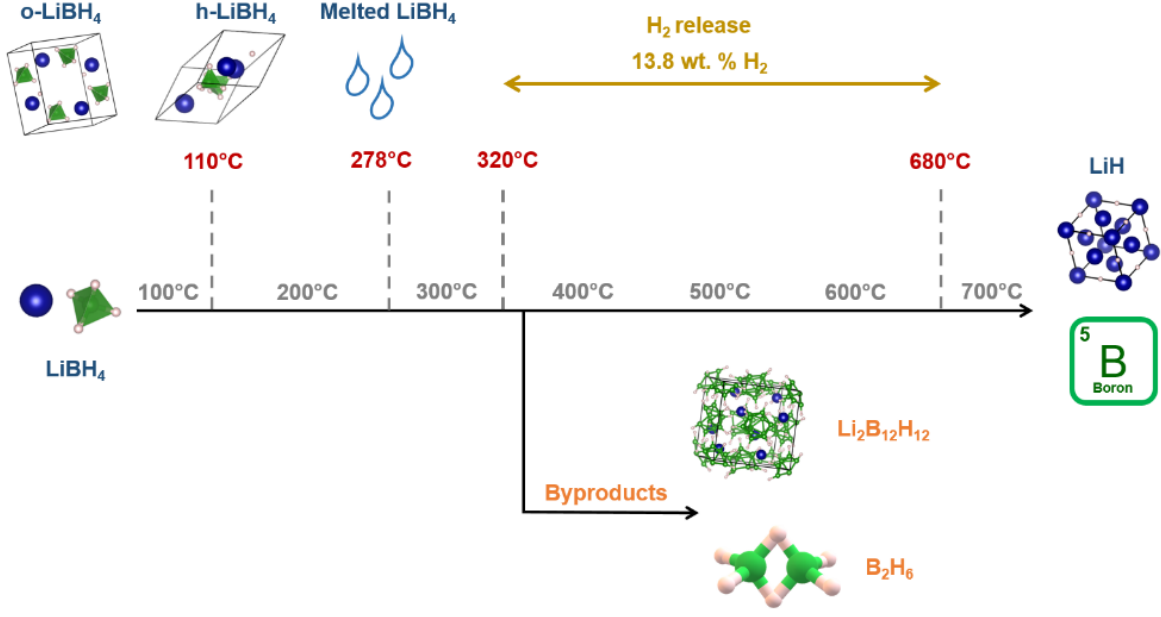
Figure 5. Thermal decomposition of LiBH 4 .